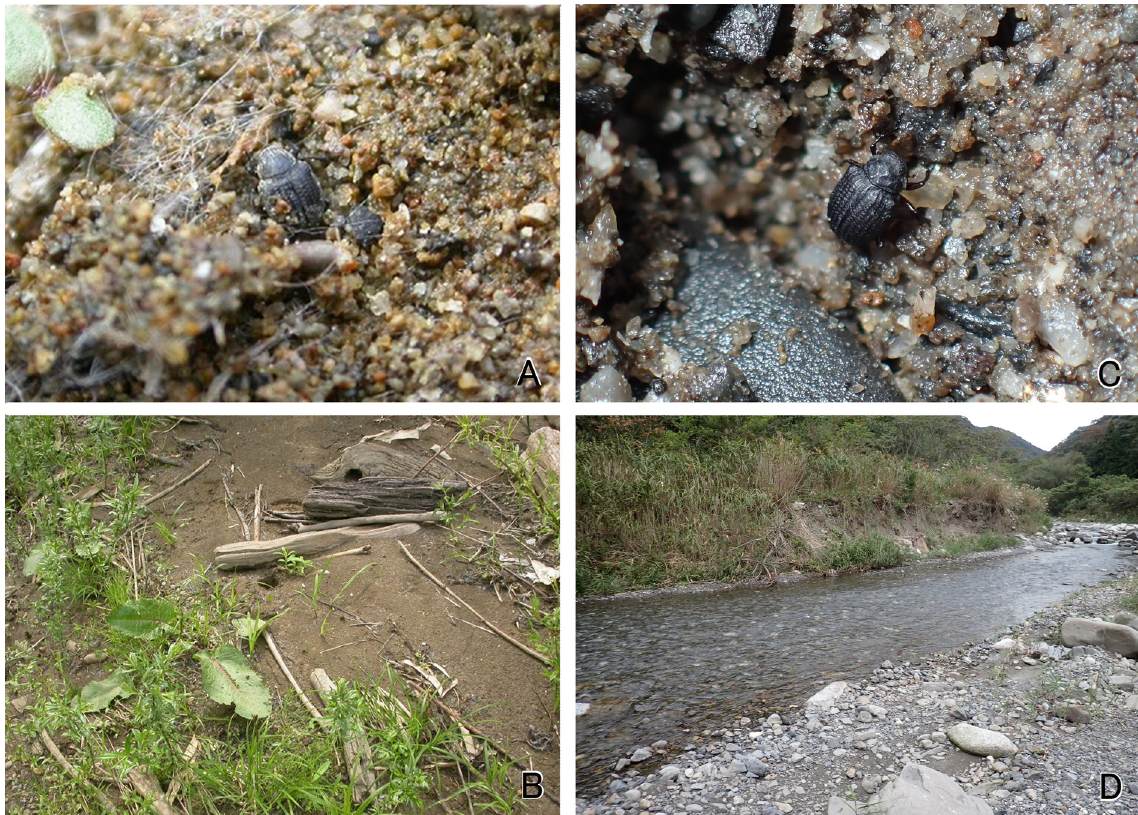
Fig. 12. Living individuals (A, C) and habitat (B, D) of Georissus spp. A–B . G . ( G .) canalifer Sharp, 1888 in Hokkaido; C–D . G . ( Ne .) kurosawai Nakane, 1963 in Ehime. Photographs by HY (A–B) and KY